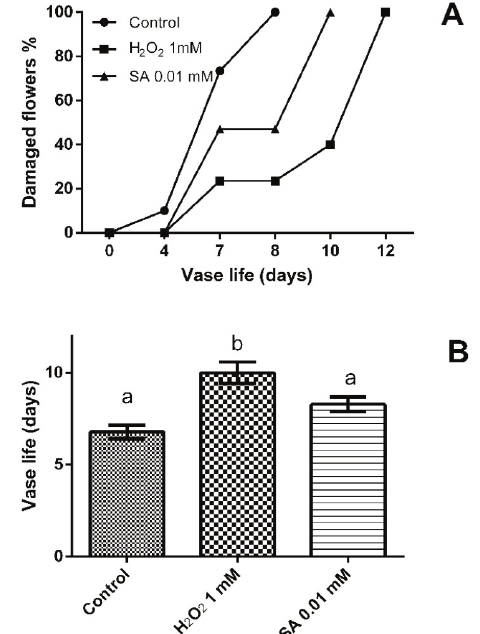
Fig. 1 - Percentage of damaged flowers (A) and average vase life (B) measured in cut ‘Tacazzi’ rose. Data are means ± SE (B: n=14; C: n=3). Different letters indicate significant dif- ferences